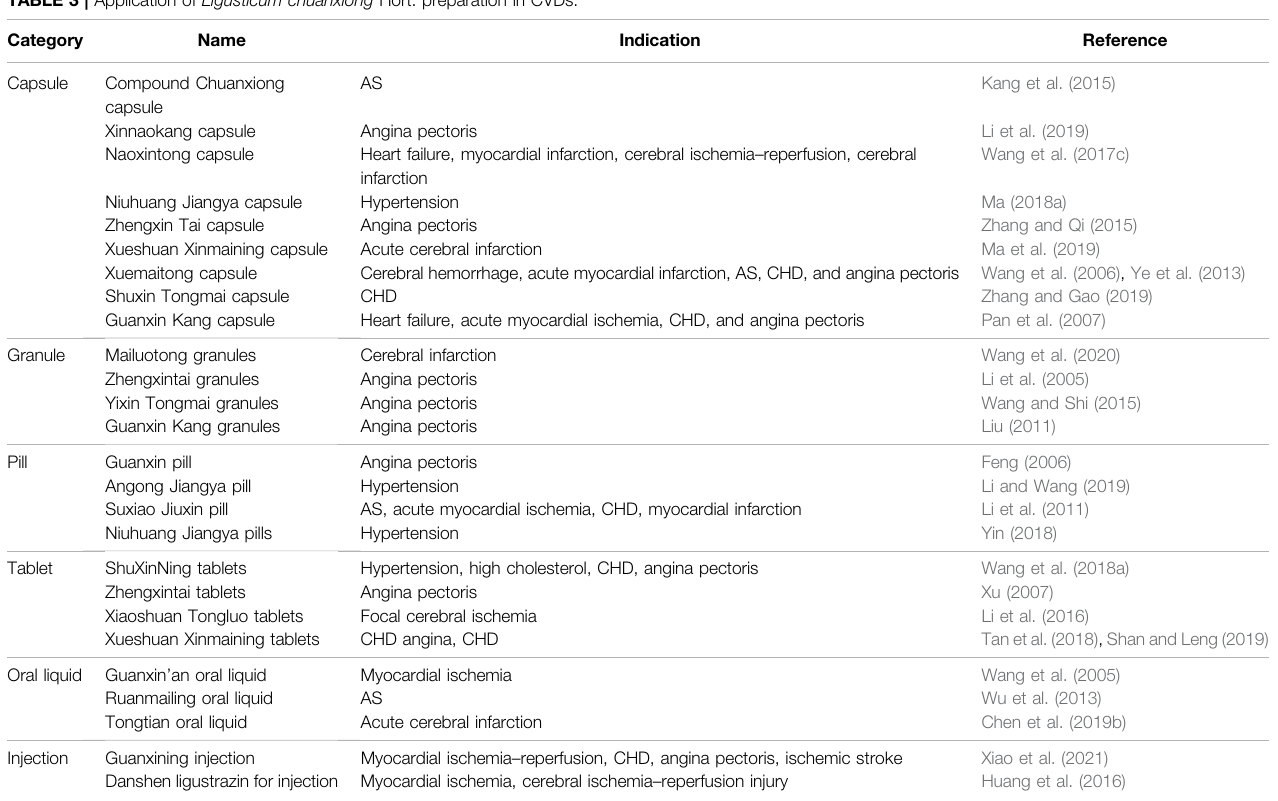
TABLE 3 | Application of Ligusticum chuanxiong Hort. preparation in